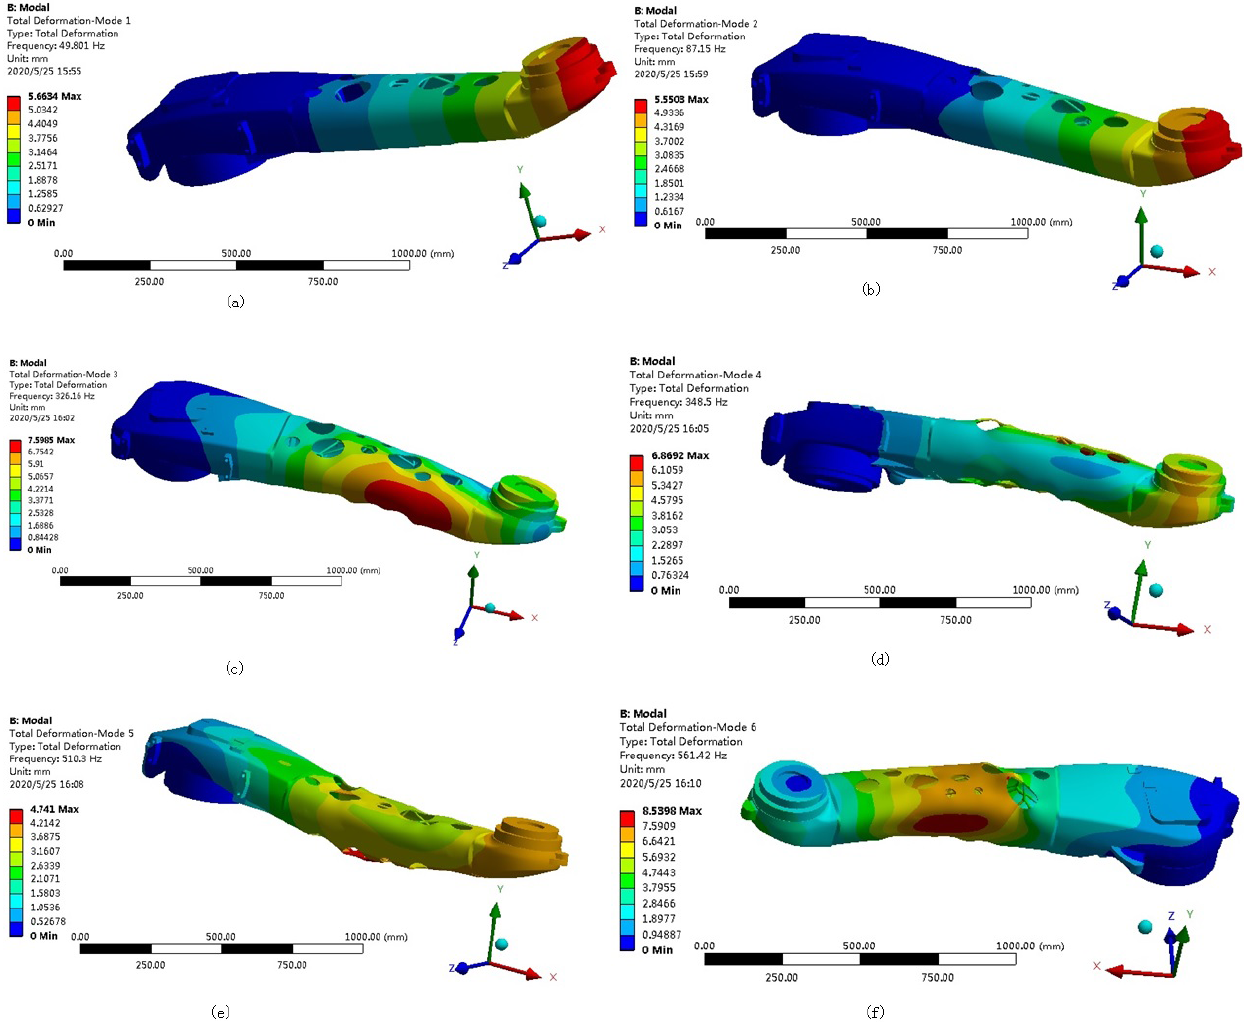
Figure 16. First six-order modes of the bone-filled forearm: (a) first-order mode; (b) second-order mode; (c) third-order mode; (d) fourth- order mode; (e) fifth-order mode; (f) sixth-order mode.